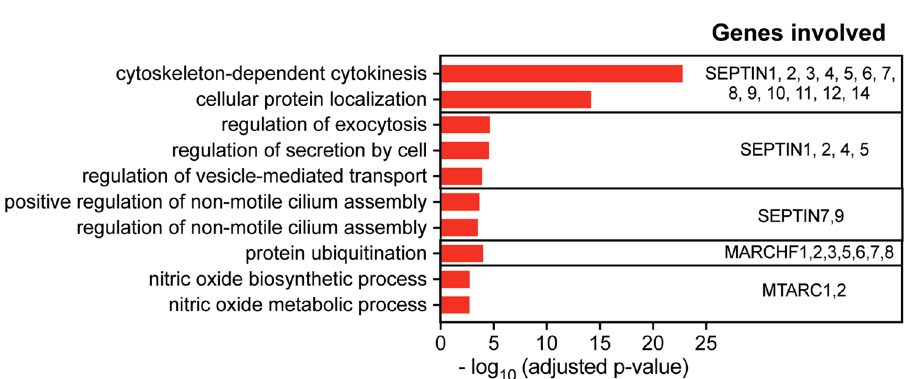
Figure 2. Top 10 enriched pathways based on genes that are frequently converted to dates in Excel. Genes were analysed against the GO Biological Processes database with Enrichr, and all presented pathways had adjusted p -values <